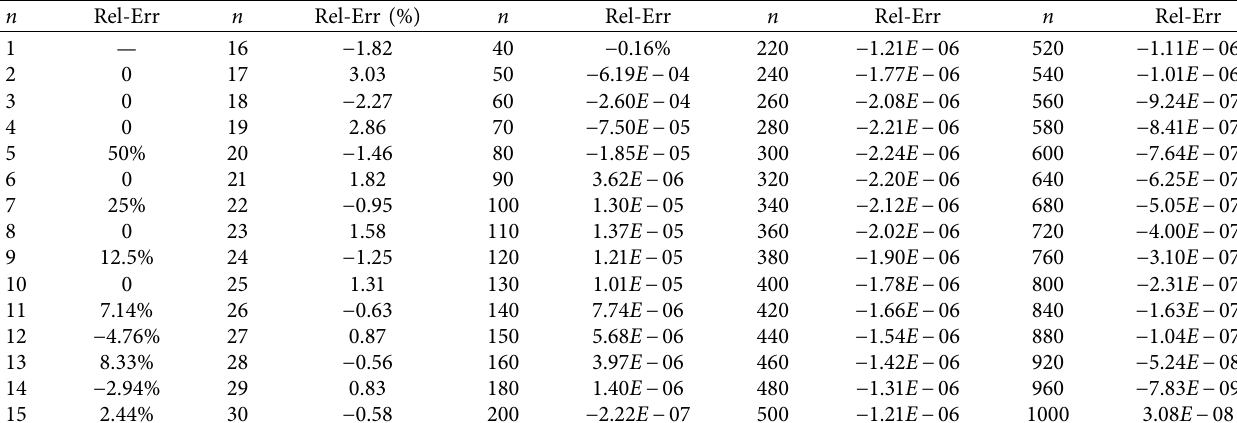
( n ) + ( 1/2 ) 􏼄 􏼅 to h ( n ) when n ⩽ 1000. 7 b